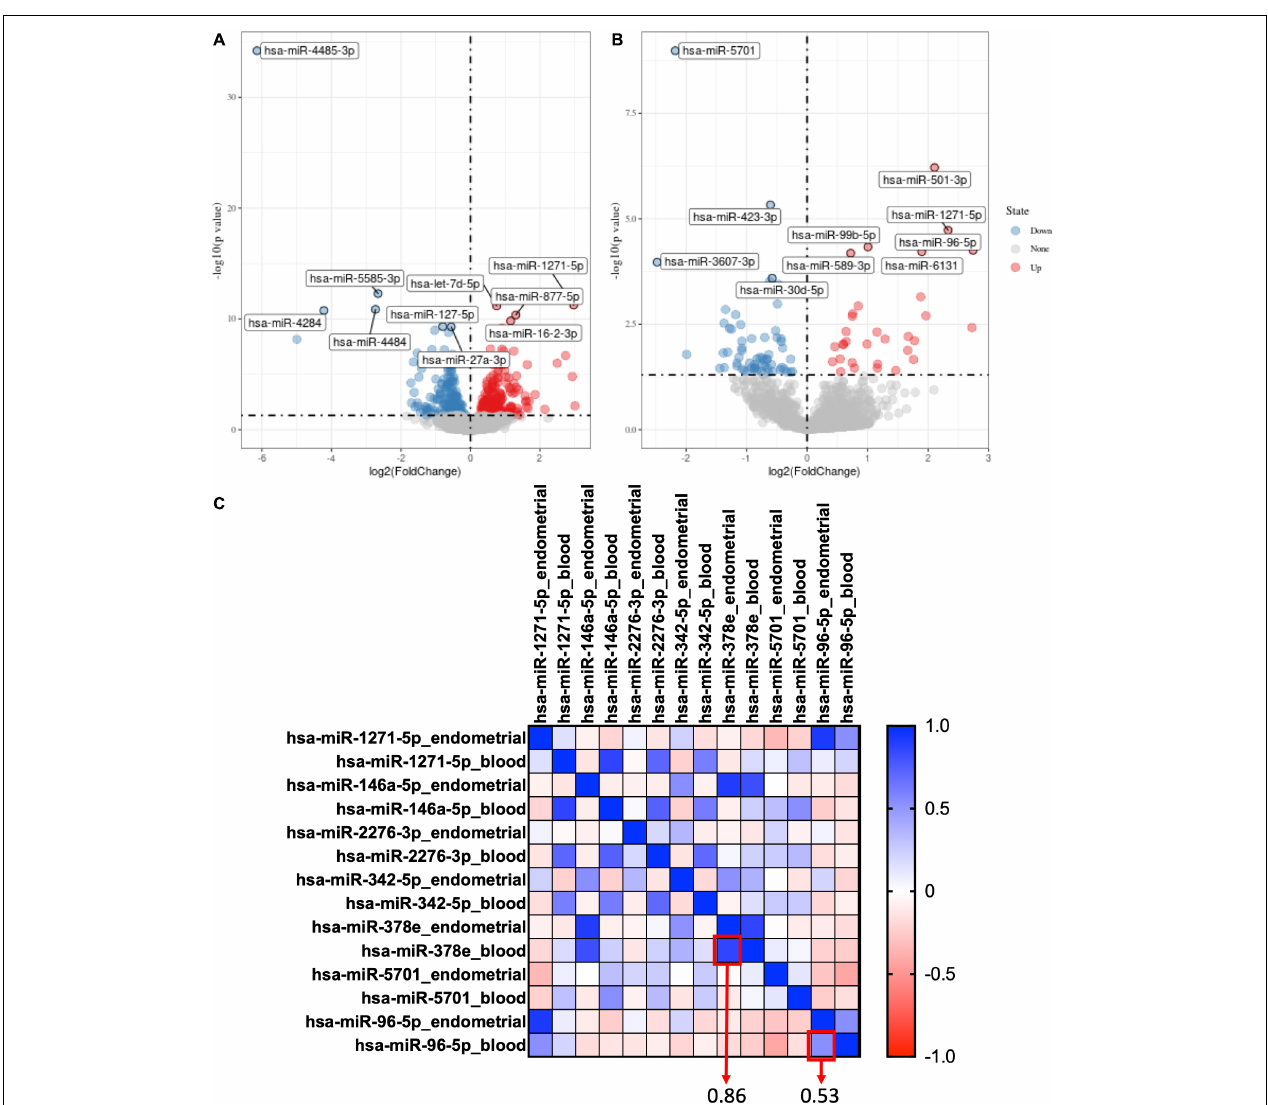
FIGURE 1 | Selection of co-expression miRNAs between serum and endometrial samples. (A) The volcano plot of differentially expressed genes in the endometrial sample of GSE108966. (B) The volcano plot of differentially expressed genes in the serum sample of GSE108966. (C) The heatmap of the co-expression miRNAs between serum and endometrial samples. The numbers inside the boxes stand for correlation coefficient.